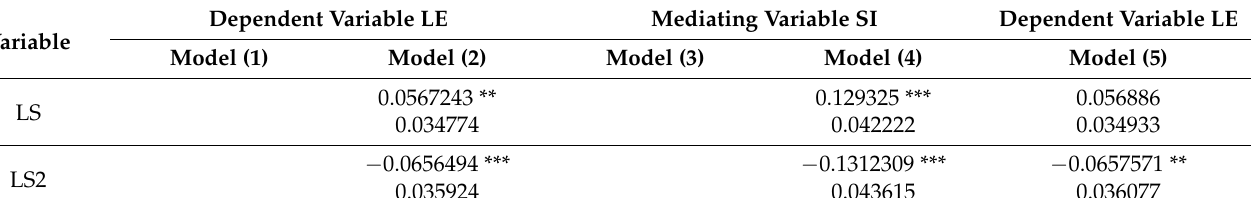
Table 6. Hierarchical regression